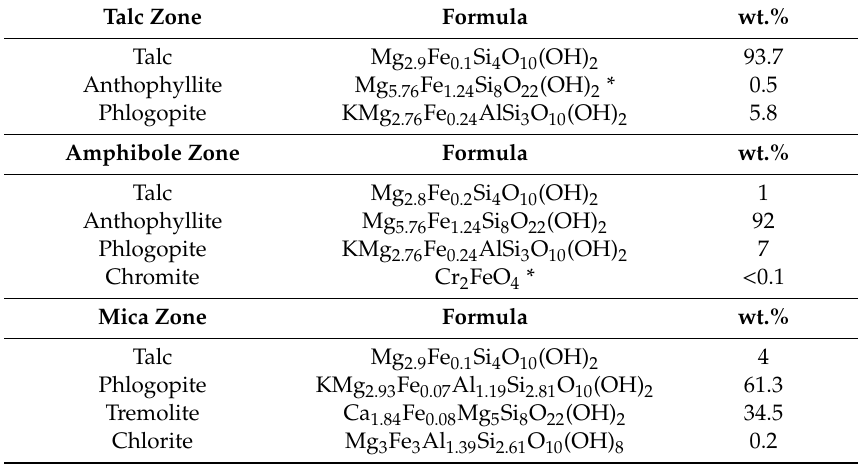
Table 5. Mineral compositions and proportions obtained by a Rietveld refinement of the PXRD data.